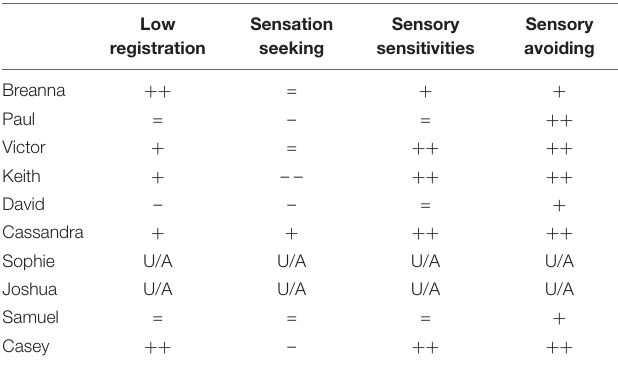
TABLE 3 | Scores from the Adolescent and Adult Sensory Profile (AASP) of the autistic individuals implicated in the participatory photovoice project 2018–2021